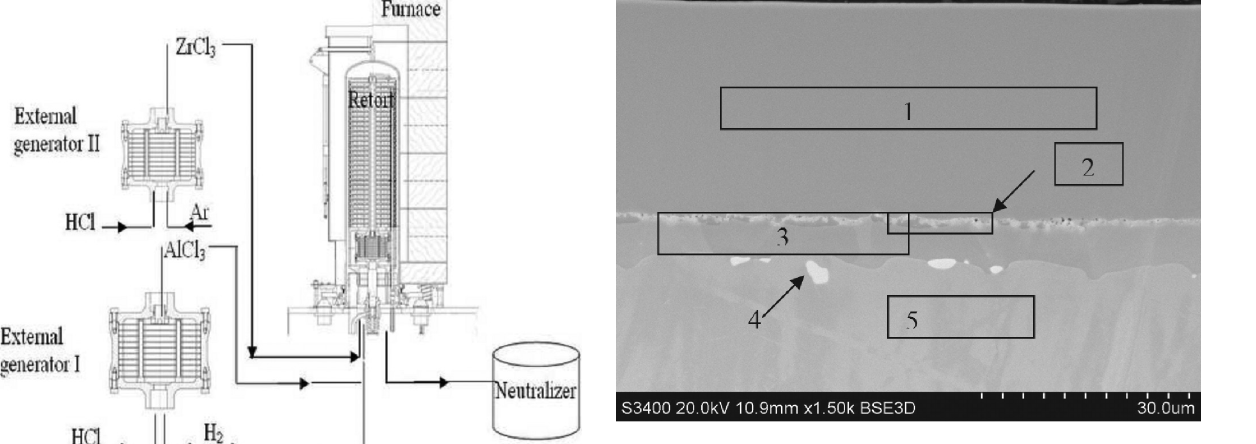
Fig. 5: Microstructure of the coating after the CVD aluminizing process after 8 h at 1325 K. Table 1: Chemical composition of the coatings after the CVD aluminizing process after 8 h at 1325